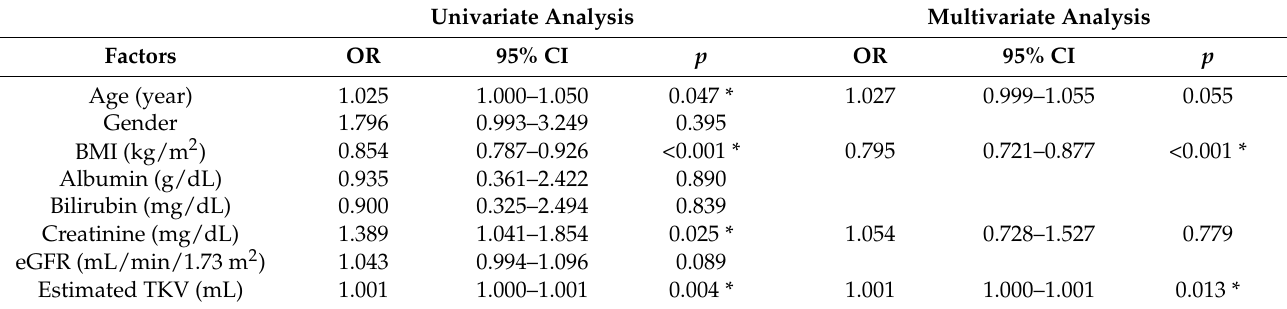
Table 3. Univariate and multivariate analysis of factors associated with sarcopenia (TAM index of <52.4 cm 2 /m 2 in men and <38.5 cm 2 /m 2 in women). Univariate Analysis Multivariate